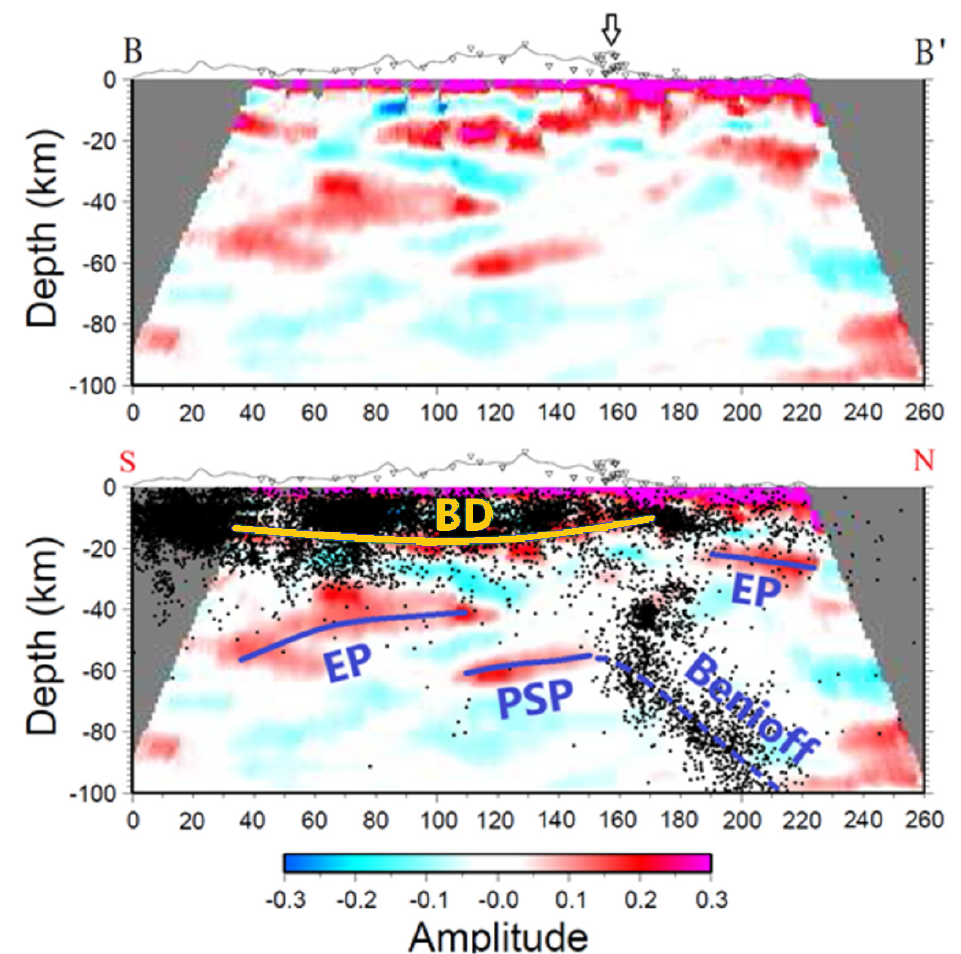
Figure 6. The CCP stack of receiver functions along the B-B ′ profile (south–north direction). The top figure is the CCP stack of receiver functions along the profile. The bottom figure is the interpretation of the top figure and incorporated with the earthquakes relocated by Wu et al. [29] for magnitude (ML) ≥ 3.0 in the past 15 years. The blue dashed line represents the Benioff seismic zone. The yellow line is the brittle–ductile transition zone in the upper crust. The blue lines indicate the Moho discon- tinuities of the Eurasian Plate (EP) and Philippine Sea Plate (PSP).